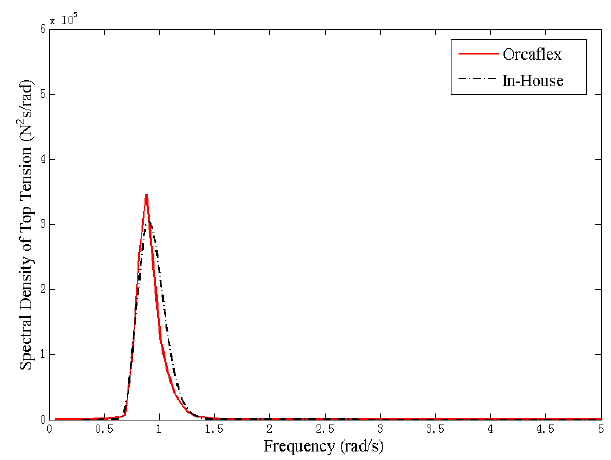
Figure 22. Top tension in time series (3 h) of multicomponent line.